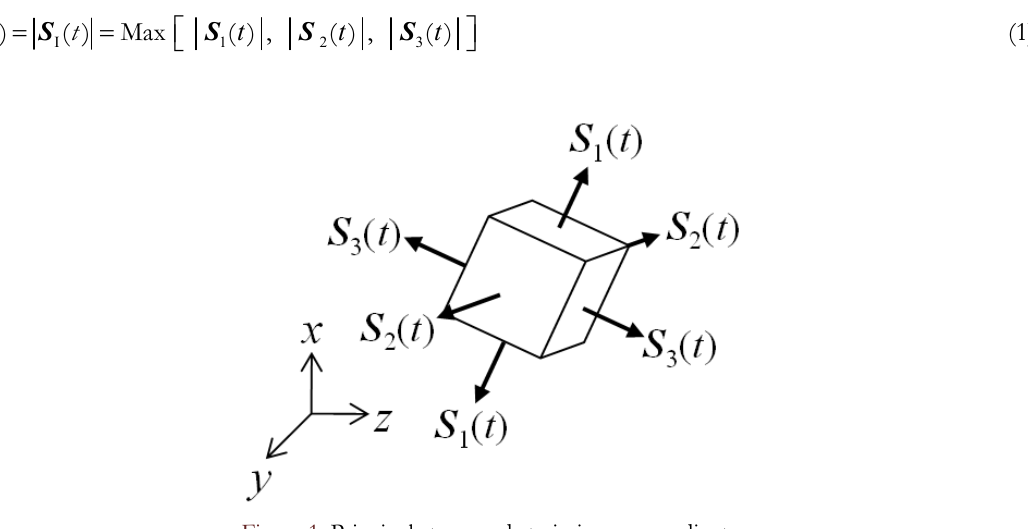
Figure 1: Principal stress and strain in xyz